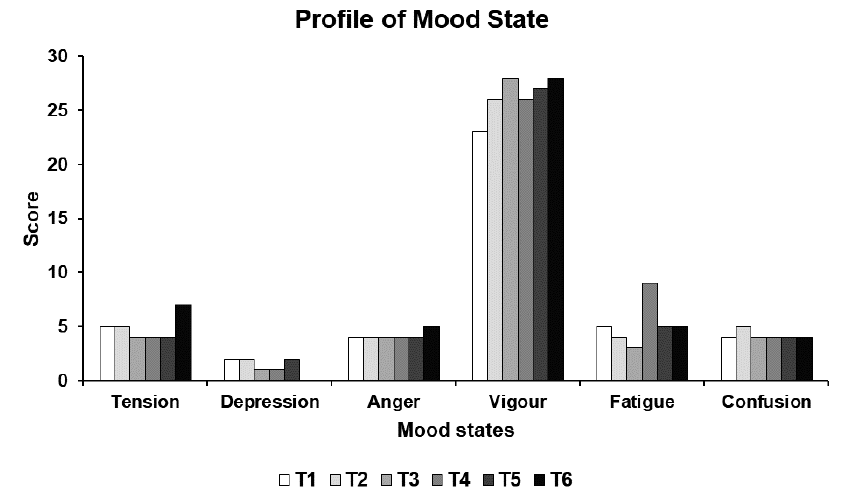
Figure 6. Results of mood states at the six test times (T1–T6).